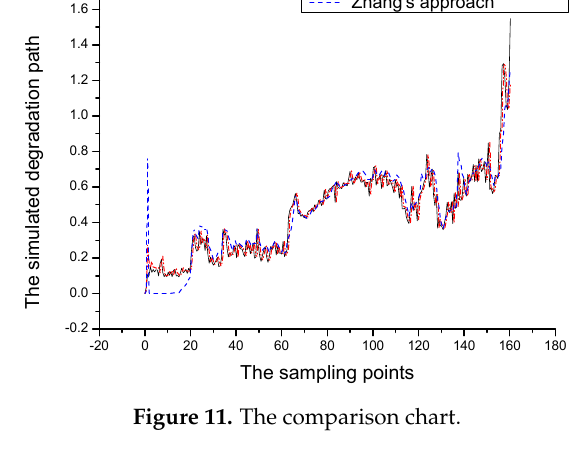
Figure 11. The comparison chart.